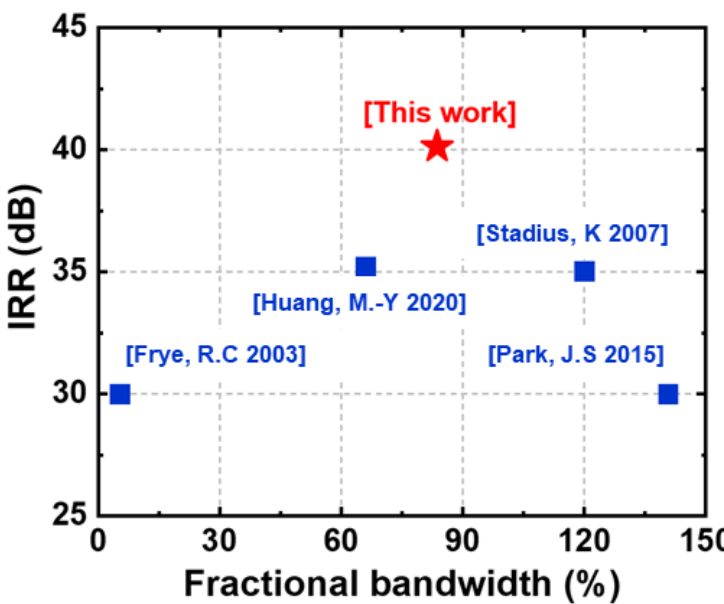
Figure 16. Comparison of wideband IRR performances